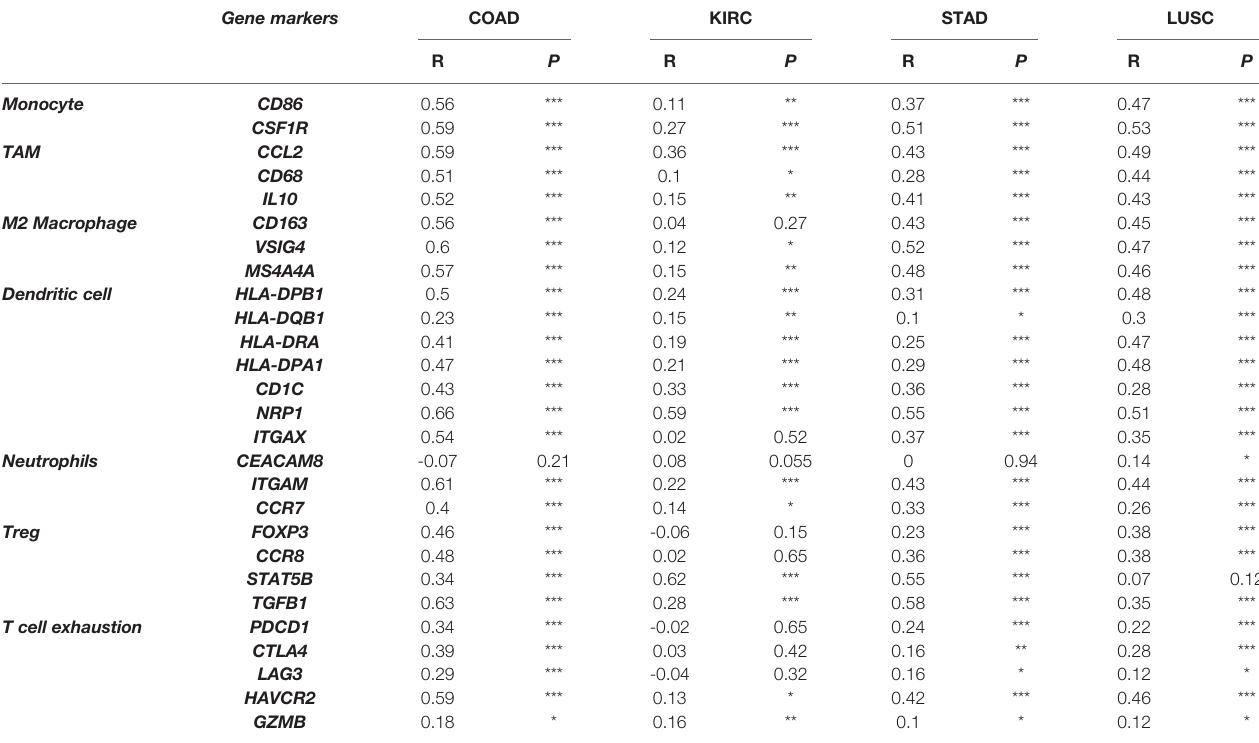
TABLE 3 | ILK expression is positively correlated with the expression of immune cell gene markers. Gene